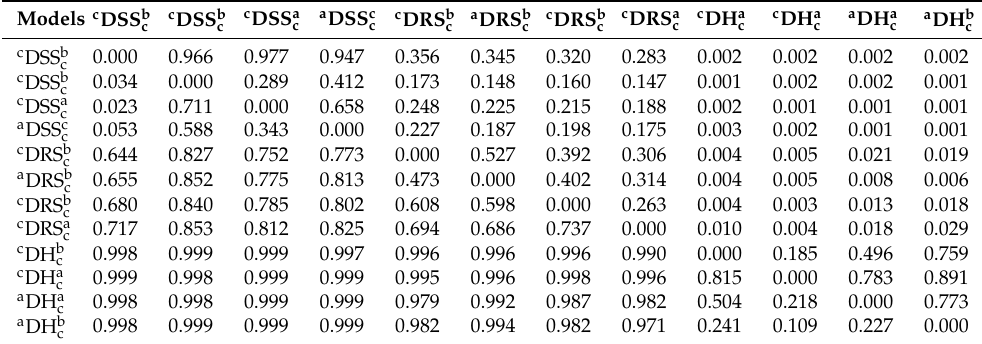
Figure 7. Performance measures: the proposed versus the literature. ( A ) MAE; ( B ) RMSE; and ( C ) MAPE. Table 7. Pakistan’s electricity consumption (kWh): results ( p -value) of the DM test for the best twelve models given in Table